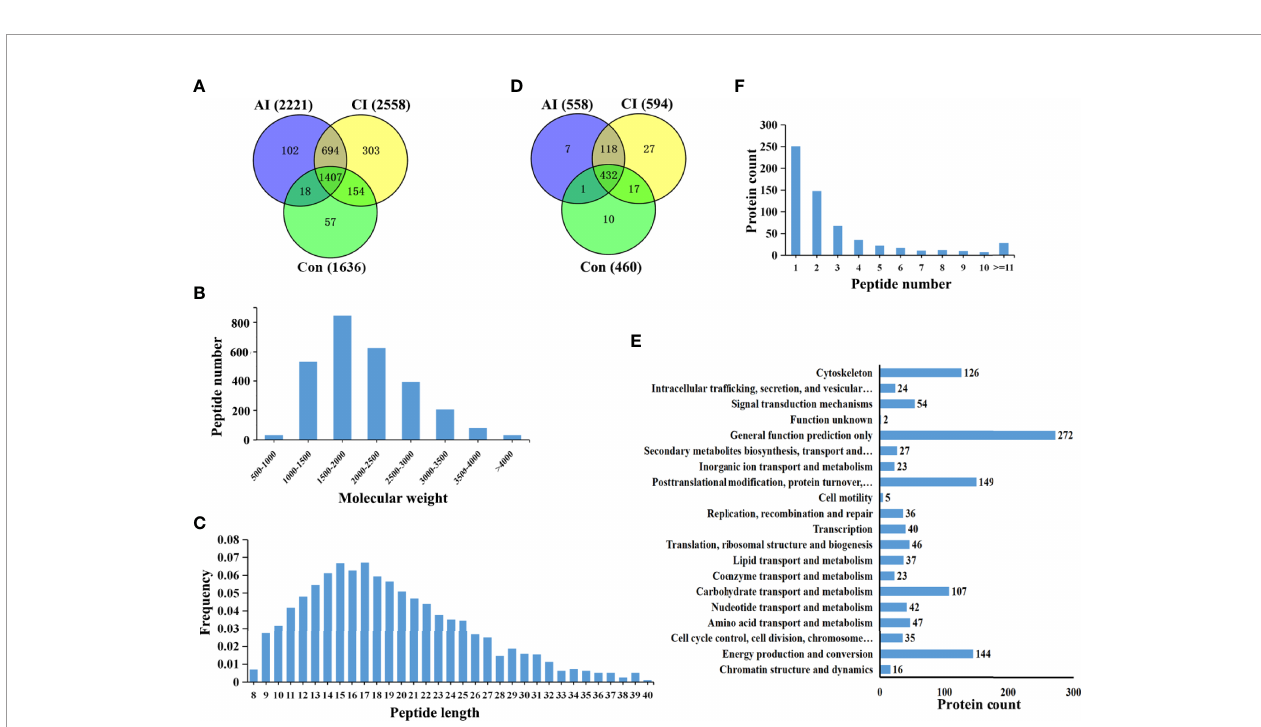
FIGURE 2 | Identi fi cation of unique endogenous peptides in mouse brains. (A) Venn diagram of identi fi ed peptides in mouse brains. (B) Molecular weight distribution of identi fi ed peptides. (C) Frequency of peptide length distribution of identi fi ed peptides. (D) Venn diagram of identi fi ed precursor proteins. (E) Distribution of the number of unique peptides identi fi ed per protein. (F) COG analysis of precursor proteins.